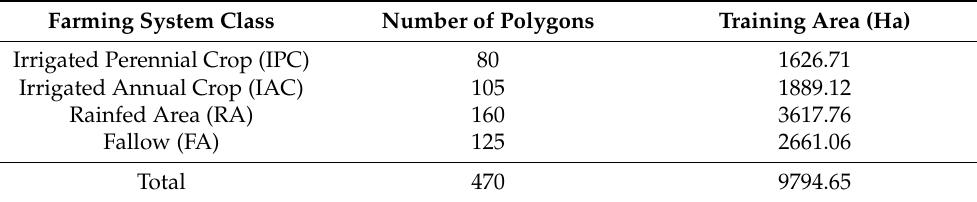
Table 3. Ground truthing